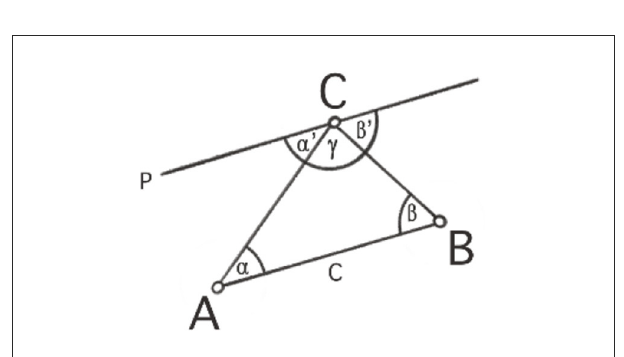
FIGURE5 Triangle with vertices A , B , C , angles α , β , γ , alternate angles α , α ’ and β , β ’ and parallel line p to c through C